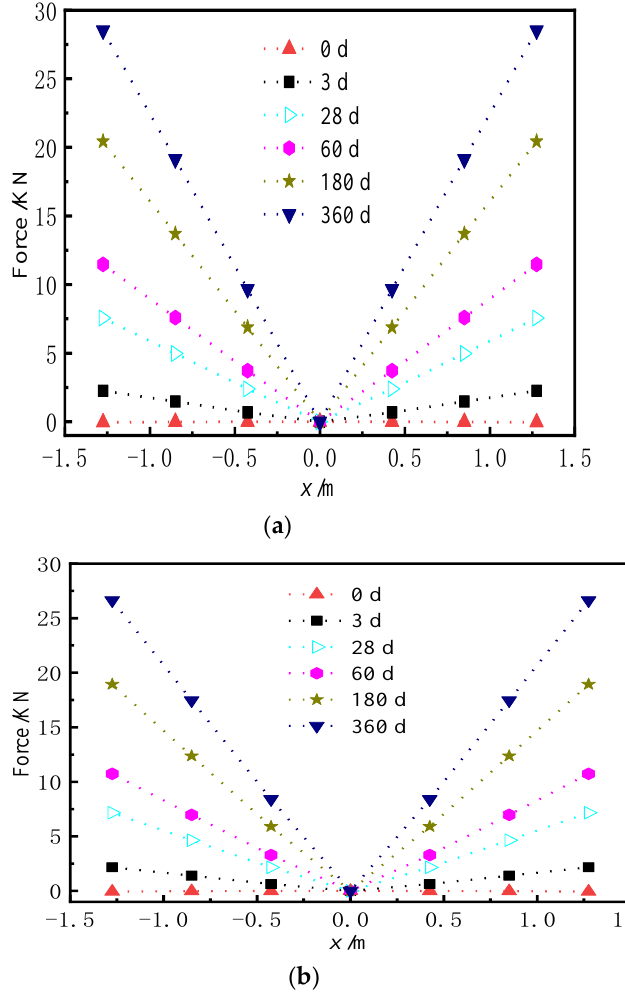
Figure 24. Lateral force of the shear cogging. ( a ) AOTSL of 60 d. ( b ) AOTSL of 360 d. As seen from Figures 23 and 24, it can be seen that the vertical and lateral additional forces are gradually generated due to the shrinkage and creep of the ballastless track. The peak value of vertical additional force appears at the middle and edge of the slab. However, the lateral additional force is the largest at the slab edge and gradually decreases towards the middle of the slab. The additional force of the shear cogging is much less than its strength limit. At the AOTSL of 60 d, as time increases, the shear cogging is under vertical tension at the slab edge and compression at the middle of the slab. When the AOTSL is 360 d, the shear cogging is under vertical compression at the slab edge and tension at the middle of the slab over time. In addition, except for the middle of the slab, the shear cogging is always in lateral tension under different AOTSL. It is found in Figure 25 that the vertical force of the shear cogging shows great discrep- ancies at different AOTSL. In detail, when the AOTSL is less than 180 d, the vertical force of the shear cogging at the slab edge changes from negative to positive with time, which indicates that the shear cogging changes from vertical compression to vertical tension. When the AOTSL is more than 180 d, the vertical force at the slab edge is always negative, indicating that the shear cogging at the slab edge is constantly in vertical compression. In the middle of the slab, the vertical force firstly increases and then decreases to negative at the AOTSL less than 180 d, which indicates that the shear cogging is in vertical compression. When the AOTSL is more than 180 d, the vertical force increases gradually with time, and the shear cogging at the middle of the slab is finally in vertical tension. In addition, the lateral force of the shear cogging at the slab edge increases with time but decreases